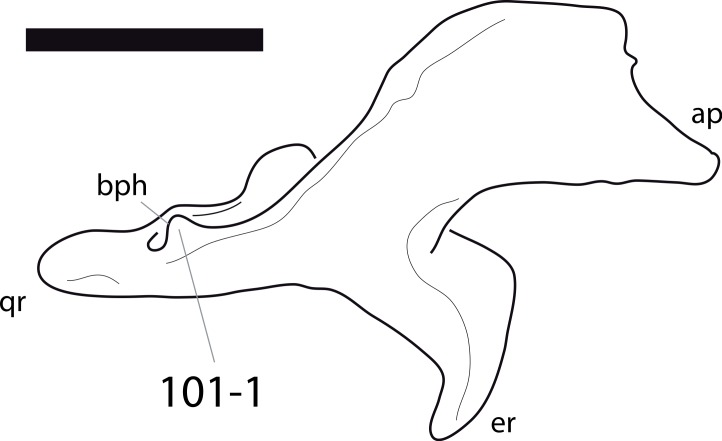
Pterygoid of Camarasaurus lentus DNM 28.Left pterygoid of Camarasaurus lentus DNM 28 in medial view. Note the presence of a hook-like process at the articulation surface for the basipterygoid process (C101-1). Diplodocidae, on the other hand, only have shallow articular facets without hooks. Abb.: ap, anterior process; bph, basipterygoid hook; er, ectopterygoid ramus; qr, quadrate ramus. Picture traced from Madsen, McIntosh & Berman (1995). Scale bar = 10 cm.